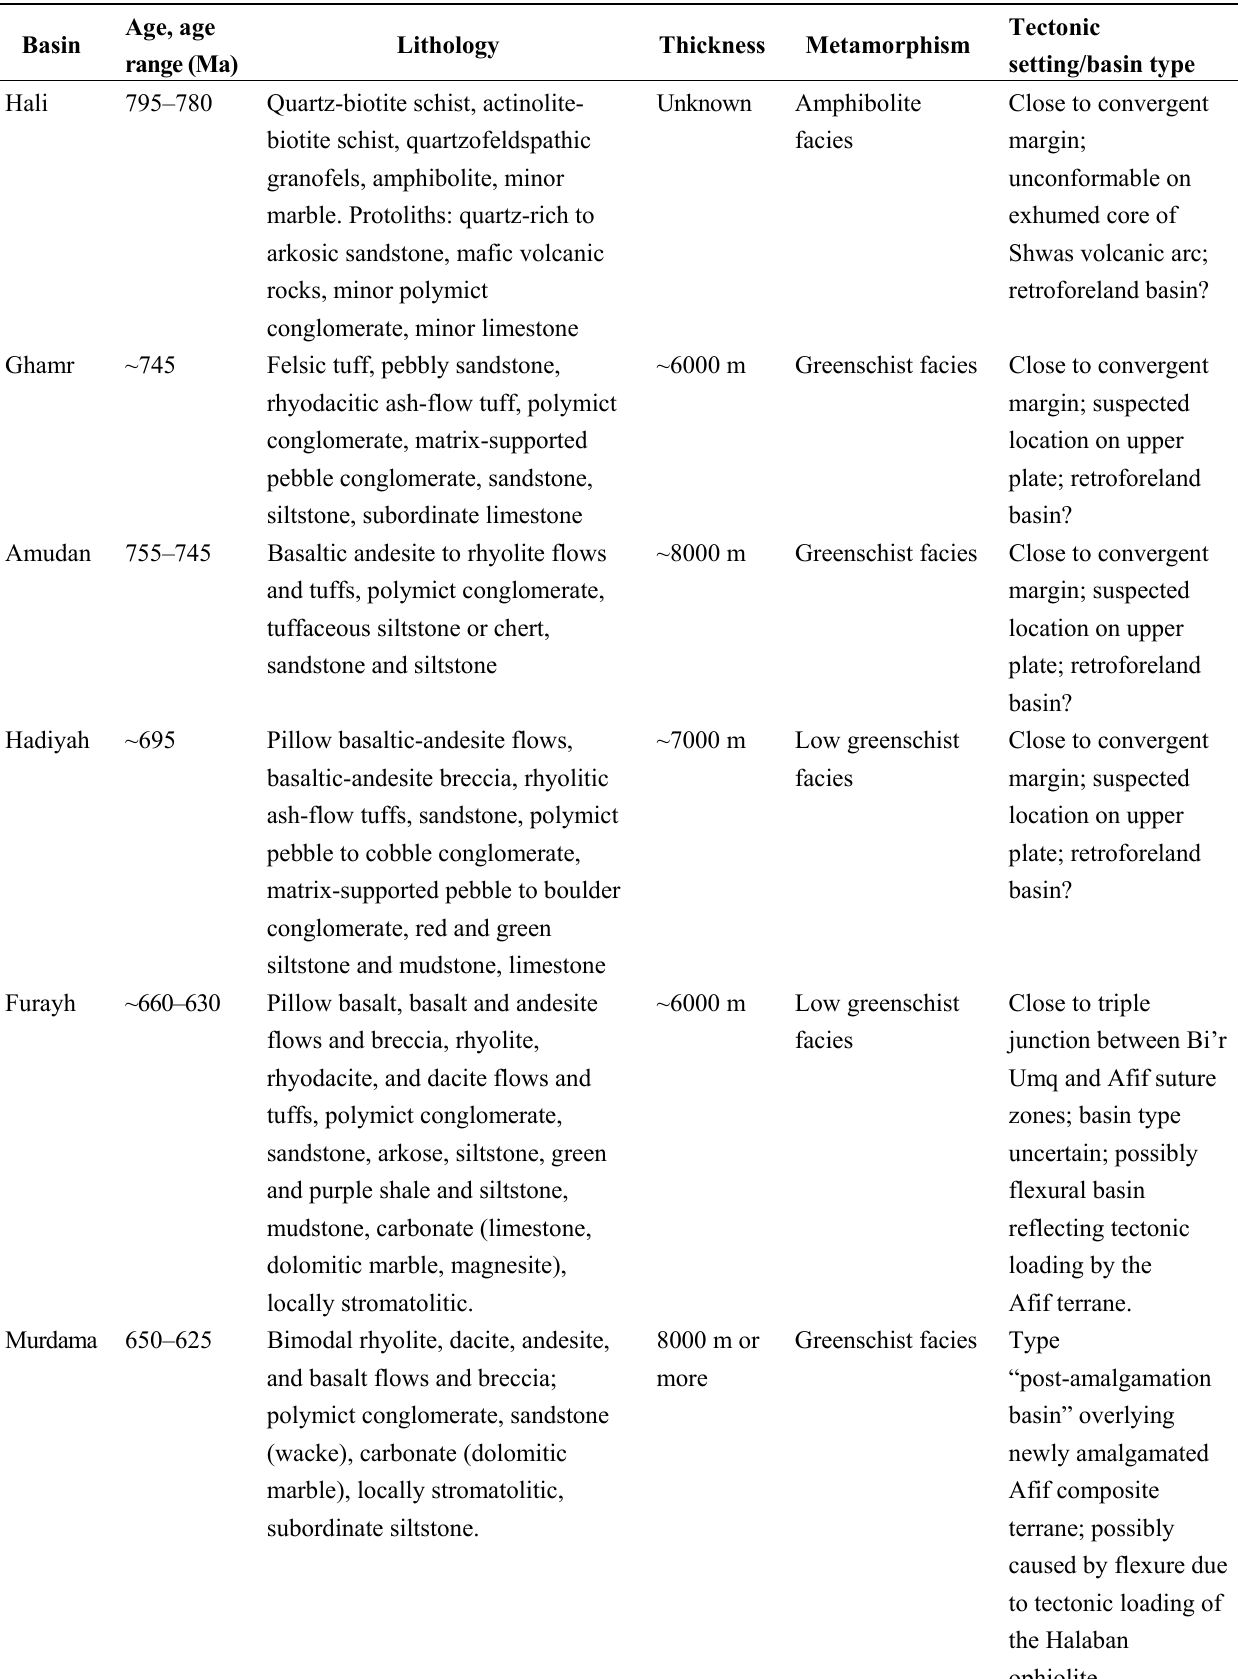
Table 1. Volcanosedimentary successions unconformable on older arc terranes in the Arabian-Nubian Shield